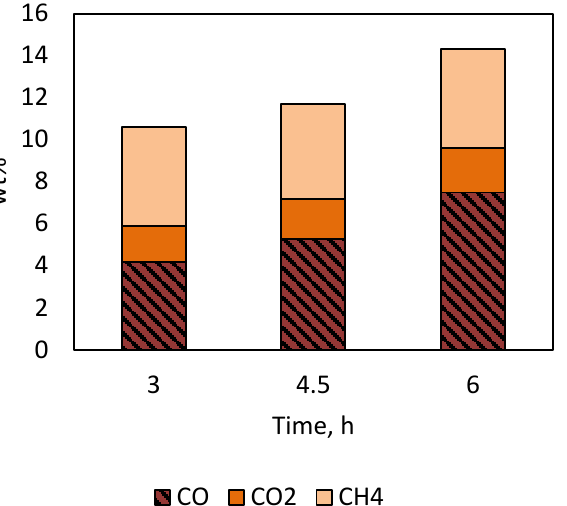
Figure 11. The effect of time of spruce wood RCF over the Ru/C catalyst at 225 °C on the yield and composition of the gaseous products.